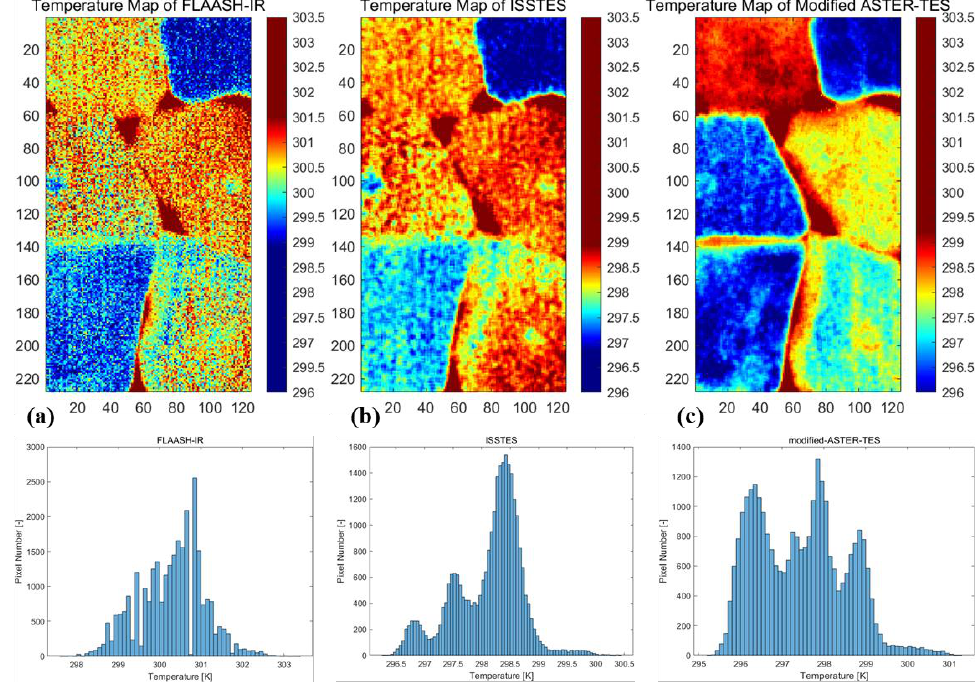
Figure 12. Retrieved temperature maps and corresponding temperature histograms: ( a ) FLAASH-IR, ( b ) ISSTES, and ( c ) modified ASTER-TES.